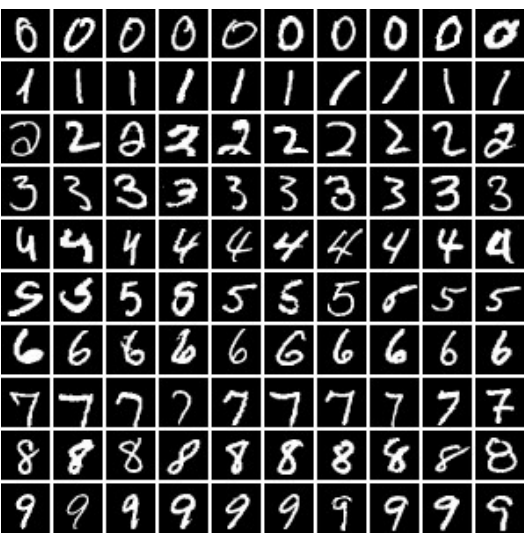
Figure 4. One-hundred digital examples, 10 per class.